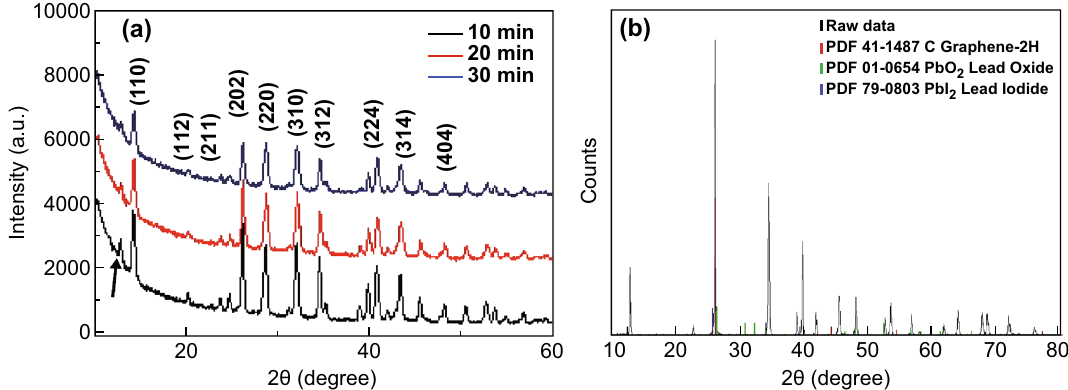
Fig. 6 XRD patterns of CH 3 NH 3 PbI 3 perovskite ultrafine nanoparticles: a after sonication in isopropanol for 10, 20, and 30 min (the peak assigned to unreacted PbI 3 is marked) and b after 20-min sonication in water. Reproduced with permission Ref. [109]. Copyright (cid:2) 2016 Elsevier B.V.